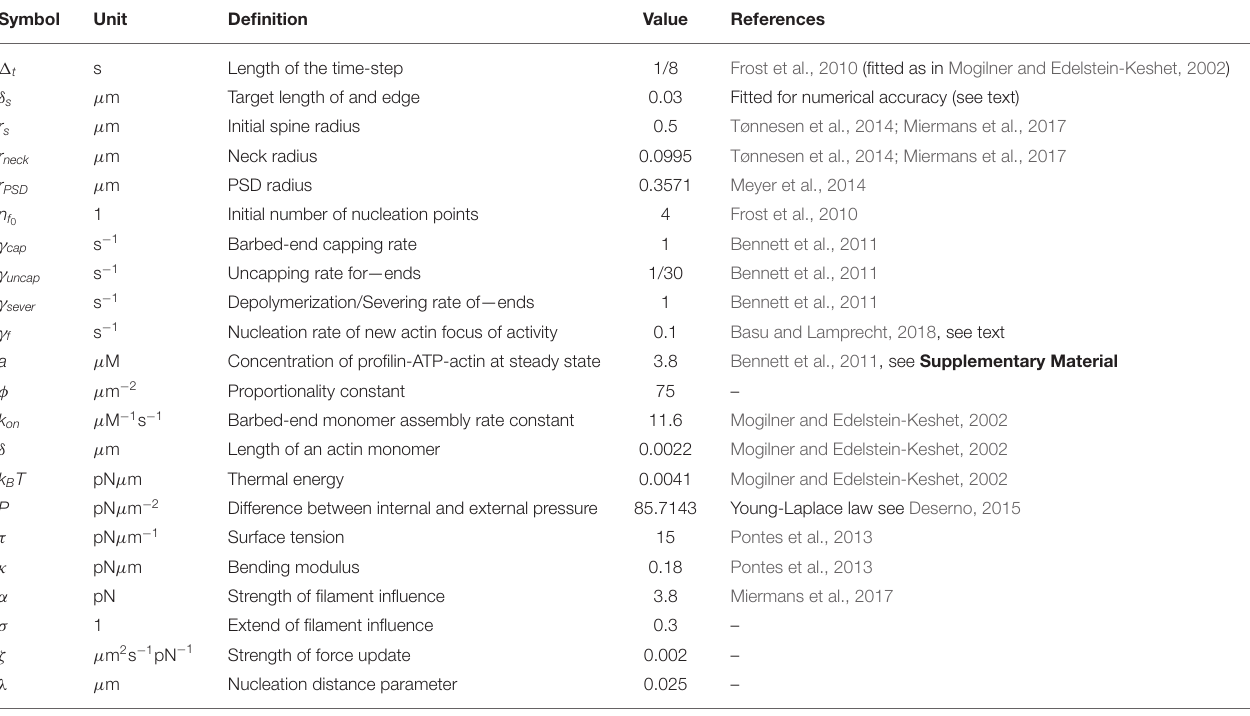
TABLE 1 | Model parameter